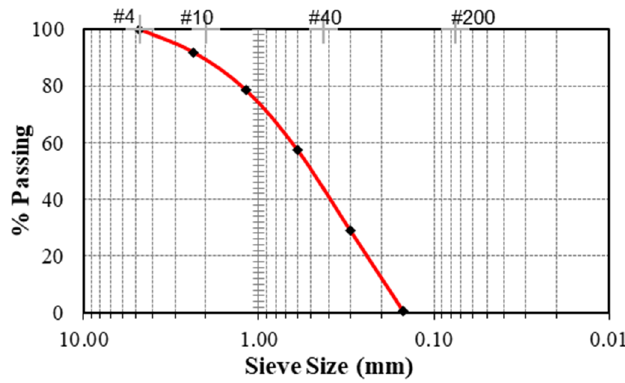
Figure 1. Grain size distribution curve for fine aggregate.